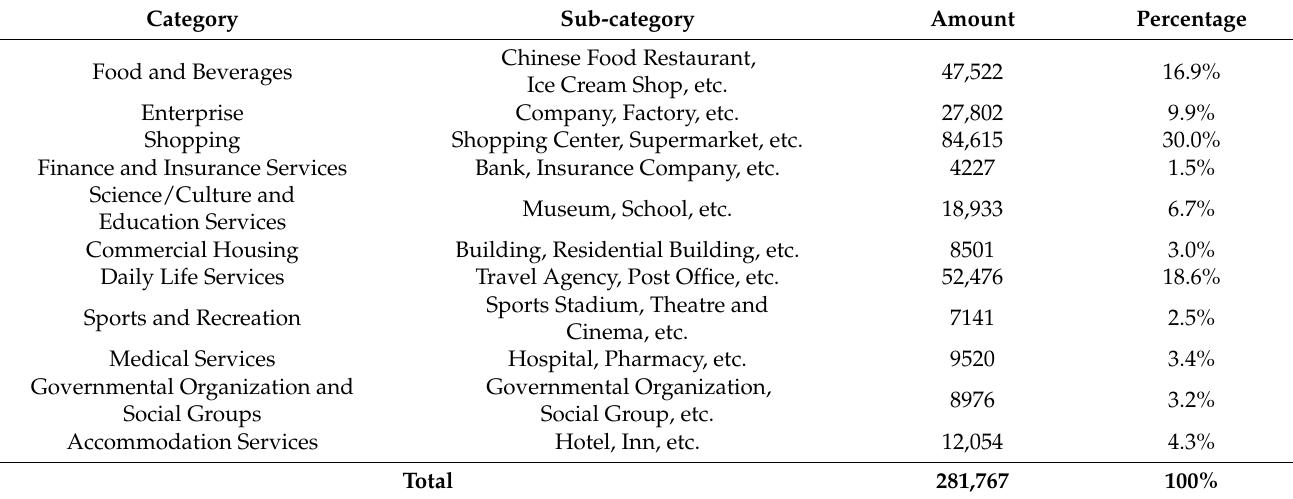
Table 1. The category and amount of original